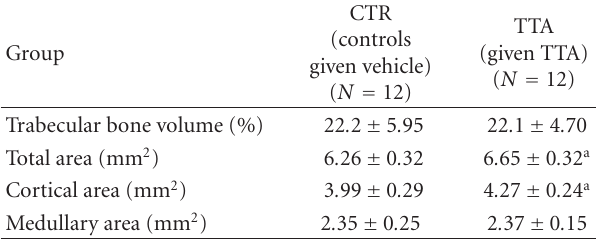
Table 2: Histomorphometric analysis of trabecular bone volume, total, cortical, and medullary area in distal femur after four months of treatment with TTA (Study